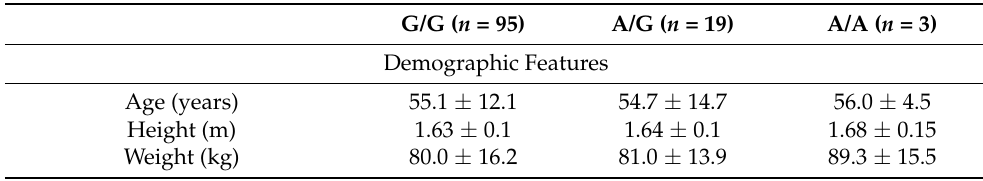
Table 4. Differences in pain phenotyping in COVID-19 survivors with post-COVID pain depending on the Tumor Necrosis Factor α (TNF- α ) polymorphism